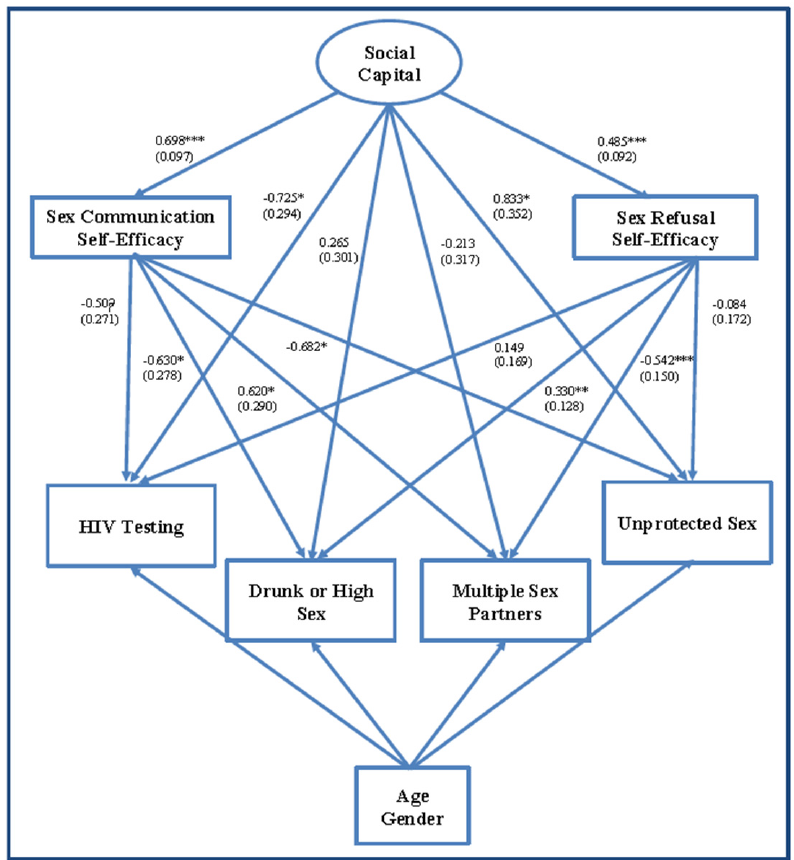
Figure 2. Results of hypothesized model linking social capital to STI/HIV risk behaviors and HIV testing through communication and sex refusal self-efficacy. Note: standardized path coefficients are presented above, below (standard error); * p < 0.05, ** p < 0.01, *** p < 0.001. Indirect associations. The association between social capital and past 90-day multiple sex partners was mediated by sex refusal self-efficacy ( β = − 0.25, p = 0.037) and marginally significant by sex communication self-efficacy ( β = 0.45, p = 0.076). The association between social capital and past 90-day drunk or high prior to sex was partially mediated by sex refusal self-efficacy ( β = − 0.15, p = 0.09) and sex communication self-efficacy ( β = − 0.45, p = 0.07). Finally, the effect of social capital on lifetime HIV testing was partially mediated by sex communication self-efficacy ( β = − 0.36, p =